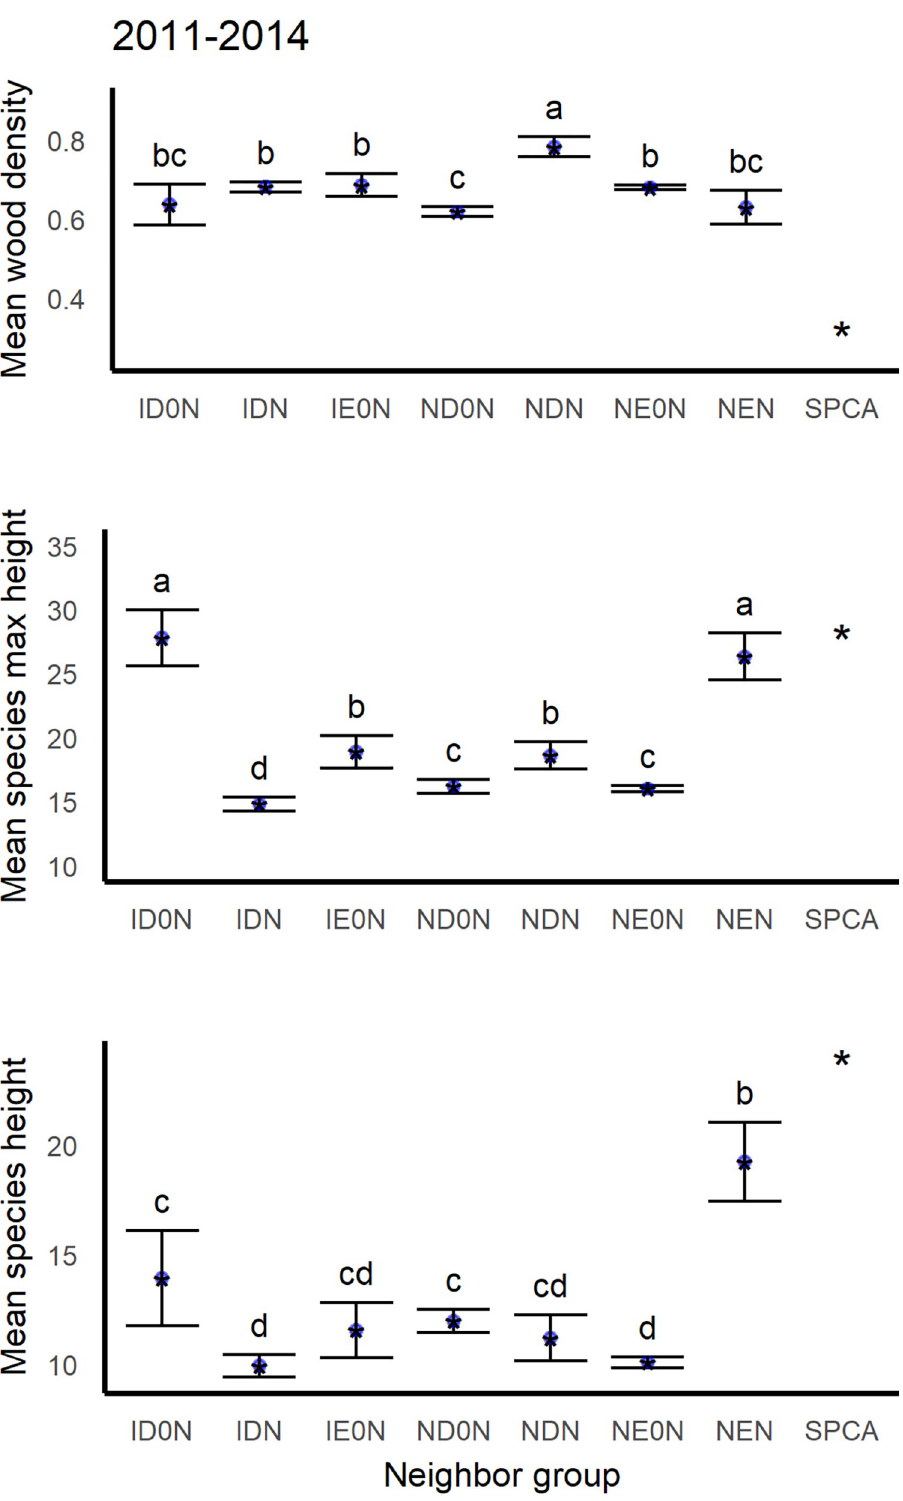
Fig 10. Mean wood density, maximum species height and typical species height of species in different neighborhood functional groups in the inventory data from the years 2011–2014. Functional groups are listed in Table